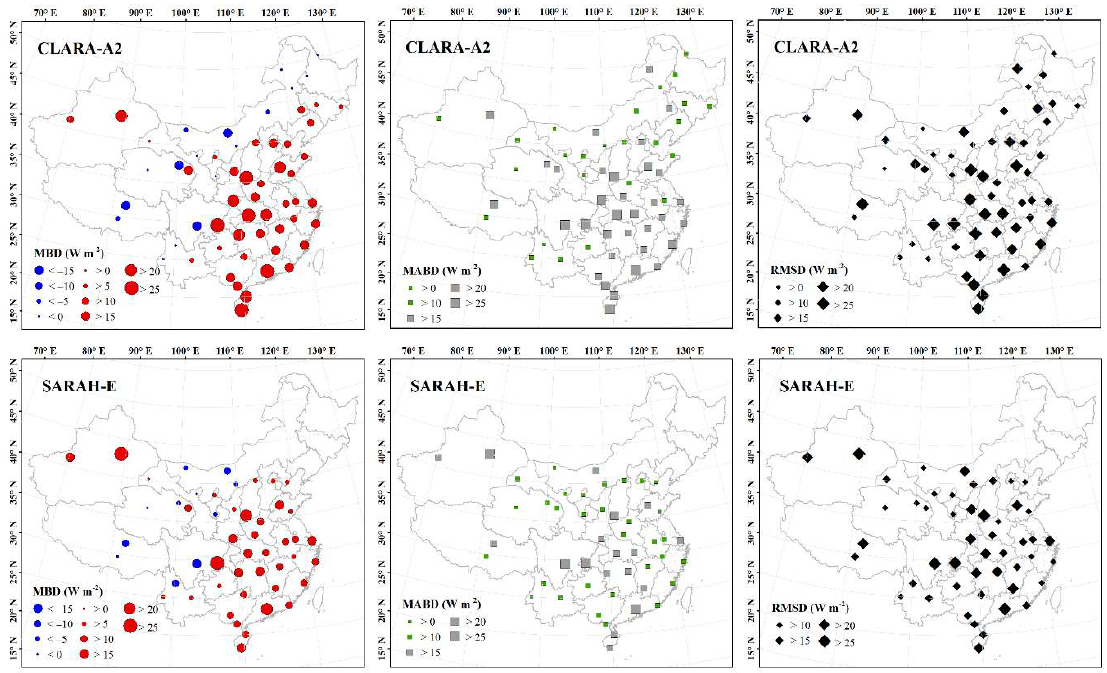
Figure 5. Spatial patterns of MBD (Mean Bias Deviation), MABD (Mean Absolute Bias Deviation) and RMSD (Root Mean Square Deviation) at the surface stations in W m −2 for the CLARA-A2 and SARAH-E radiation datasets, respectively. Red and blue circles denote negative and positive MBD, respectively. Green squares denote MABD below the accuracy threshold of 15 W m −2 , while gray squares denote the ones exceeding the threshold. Black rhombuses represent the RMSD, with the size of the rhombuses indicating the magnitude of the RMSD.